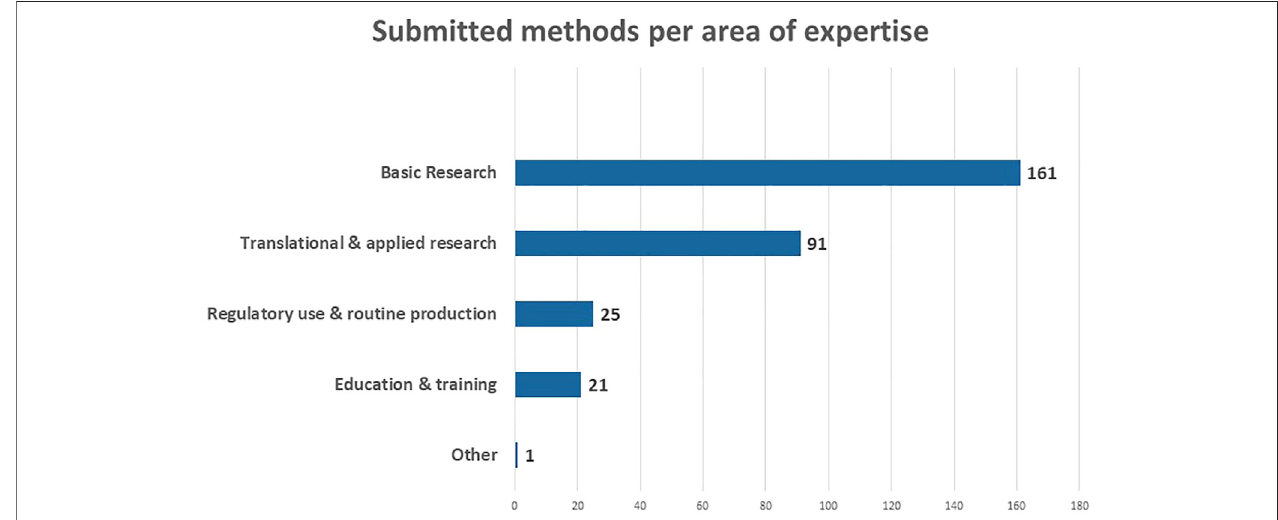
FIGURE 3 | Submitted methods according to the area of expertise in May 2022.